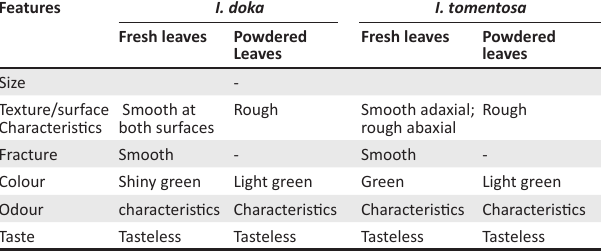
TABLE 2: Macroscopical studies of fresh and powdered leaves of I. doka and I. tomentosa . Features